Question: Judging by this figure, is the value going up or going down?
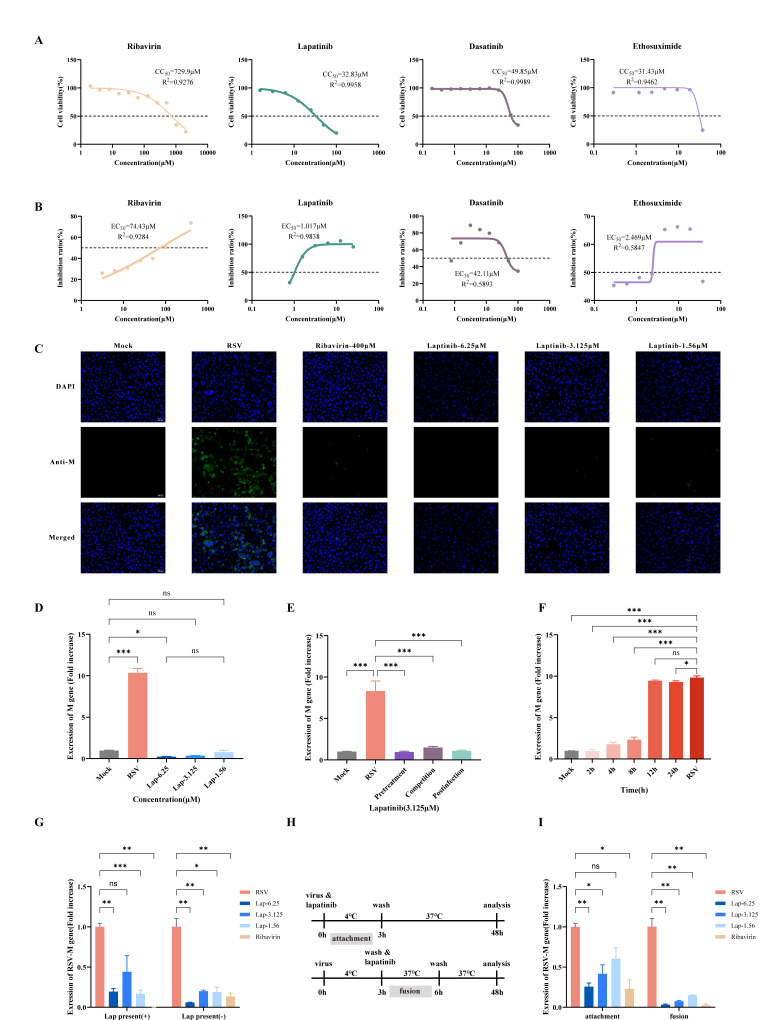
Answer: increasing